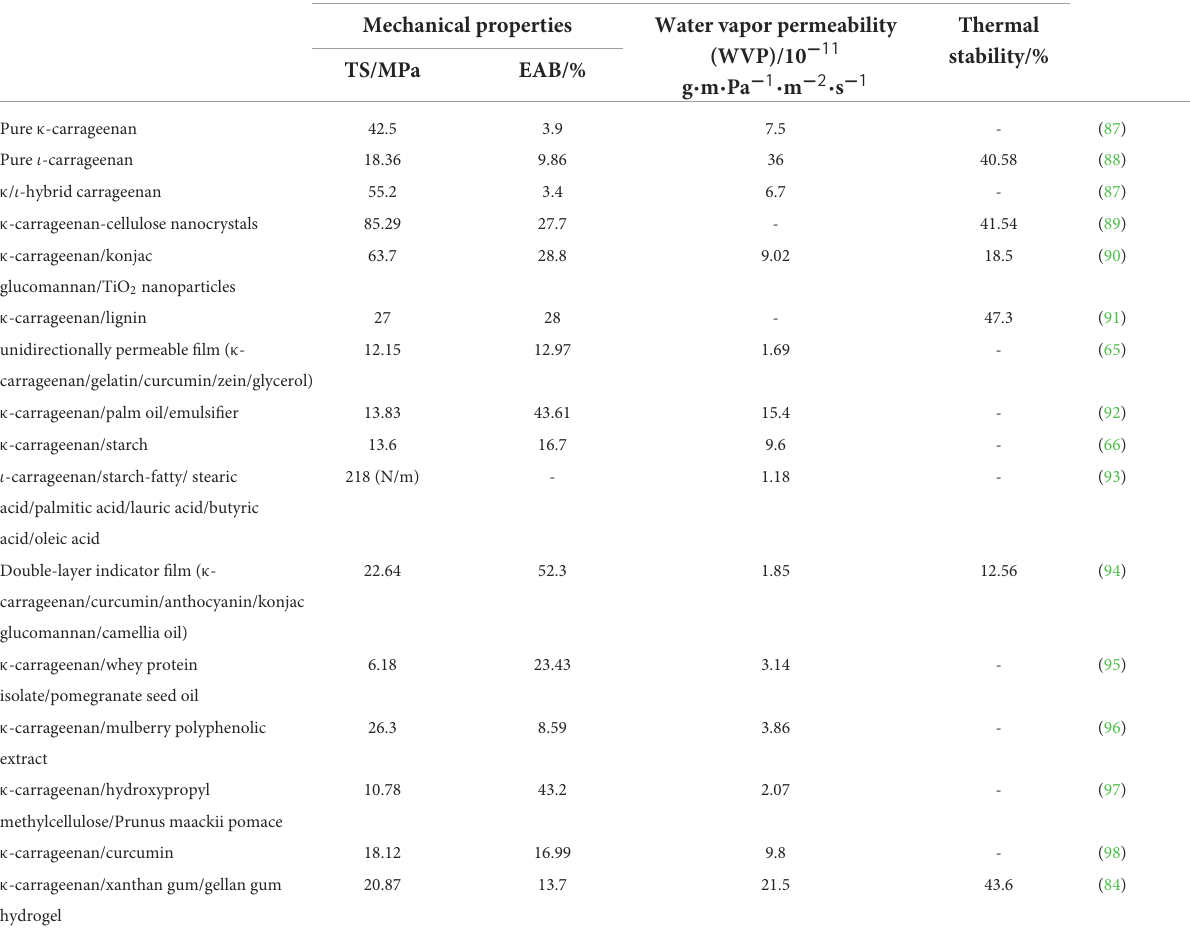
TABLE 1 The physical and chemical properties of carrageenan-based